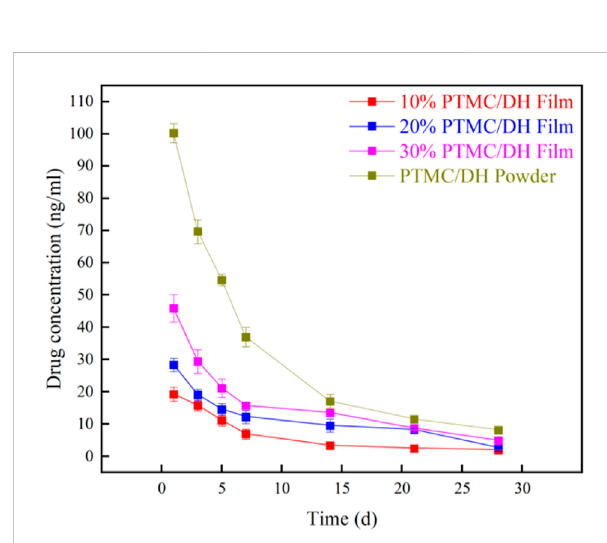
Frontiers in Bioengineering and